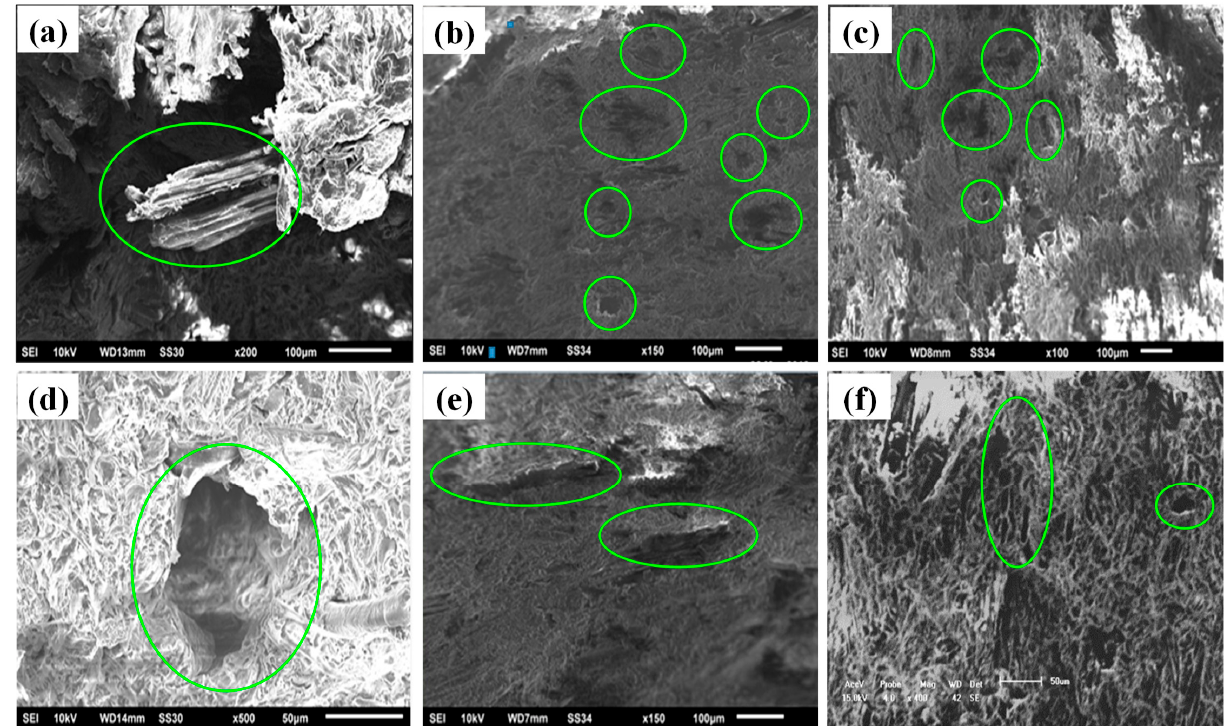
Figure 8. SEM interfacial adhesion between wood-flour and polymer matrix; ( a ) 40 mesh bamboo powder without coupling agent, ( b ) fracture surface of WPC made from 40 to 80 Bamboo Powder mesh, ( c ) effects by adding 0–3 wt.% calcium carbonate on mechanical properties of WPC, ( d ) wood powder penetrates the plastic matrix at 1 wt.% coupling agent, ( e ) effects of calcium carbonate on mechanical properties of WPC 1.5–2 wt.%, and ( f ) effects of calcium carbonate on mechanical properties of WPC 2.5–3 wt.%.